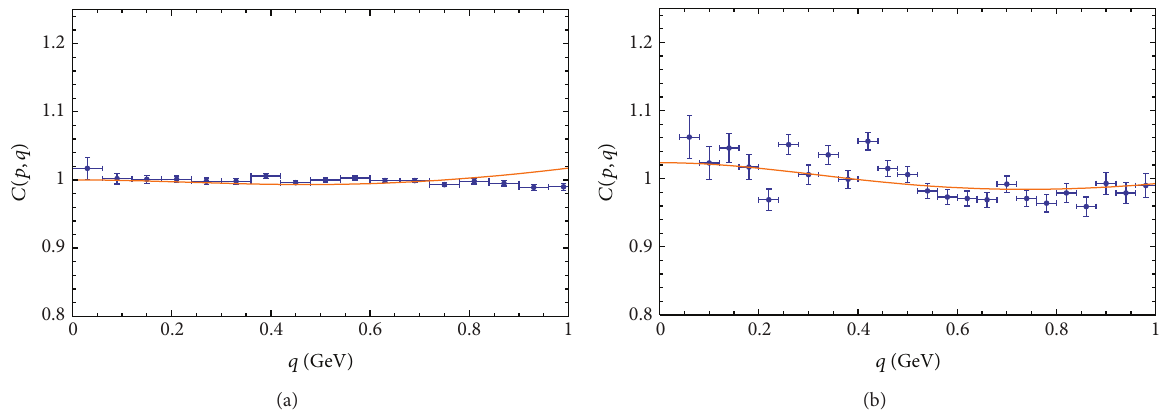
Figure 8: The nonfemtoscopic correlation functions of like-sign (a) and unlike-sign (b) pions in the 0.1 < 𝑝 𝑇 < 0.25 GeV bin from a simulation using PHOJET [41, 95] (solid dots) and those calculated from the analytical model: minijets + momentum conservation (solid line). See the text for details.